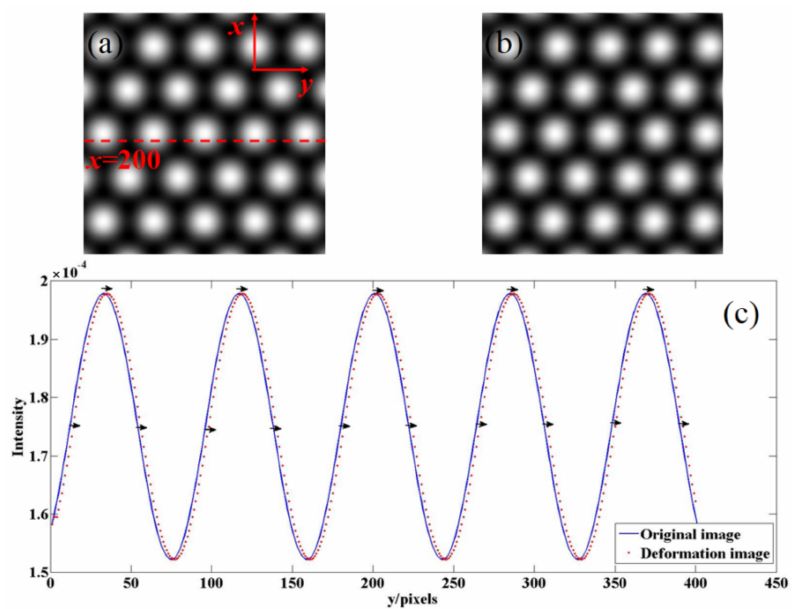
Figure 2. Simulated OFM microscopic image: ( a ) origin image; ( b ) deformation image; ( c ) intensity distributions of ( a , b ) at x = 200, y direction.